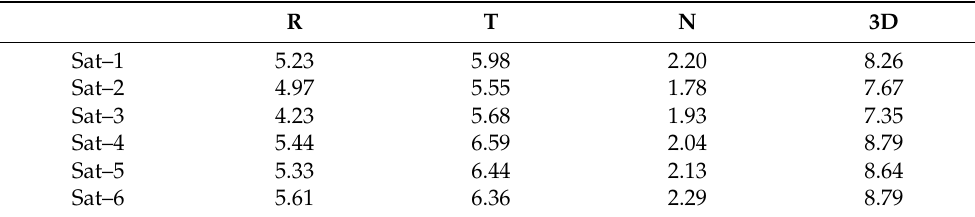
Figure 9. RMS of difference between the solved orbits and the reference ones. Table 7. Mean RMS of difference between the solved orbits and the reference ones (cm).